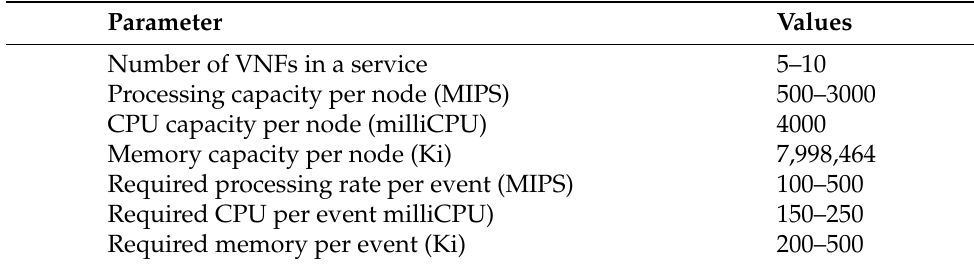
Table 2. Evaluation parameter ranges based on